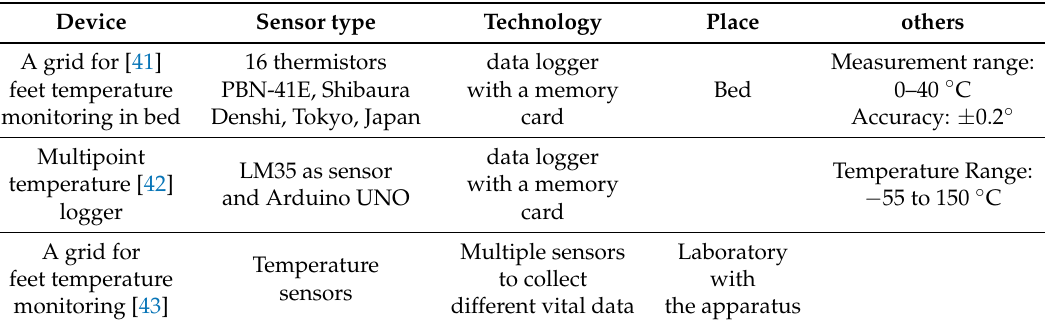
Table 2. Medical wearables specifically designed to get temperature